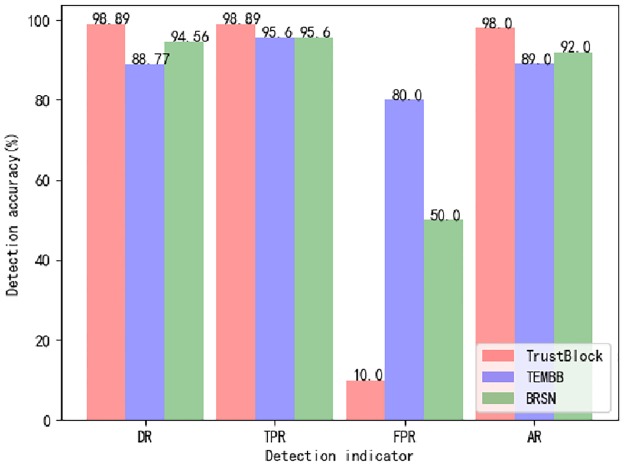
TrustBlock detection rate analysis.